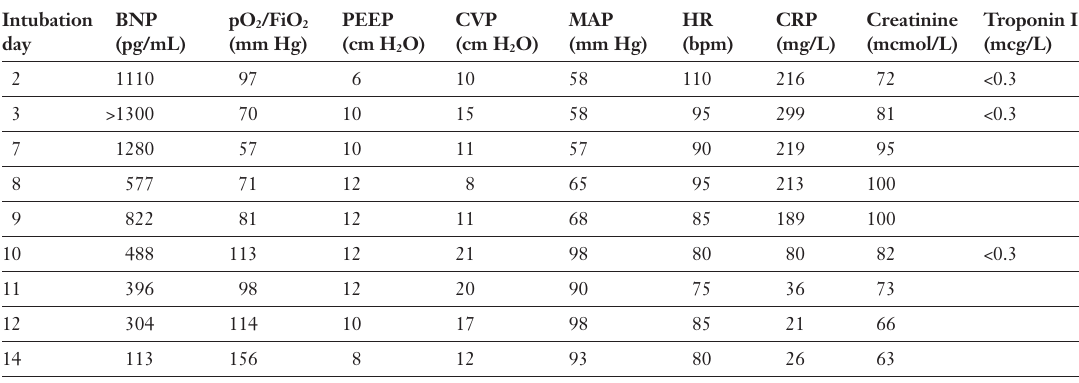
B-type natriuretic peptide (BNP) levels on nine different days while the pa- tient was intubated and corresponding clinical and labora- tory variables. PO 2 = partial pressure of arterial oxygen; FiO 2 = fraction of in- spired oxygen; PEEP = positive end-expira- tory pressure; CVP = central venous pres- sure; MAP =